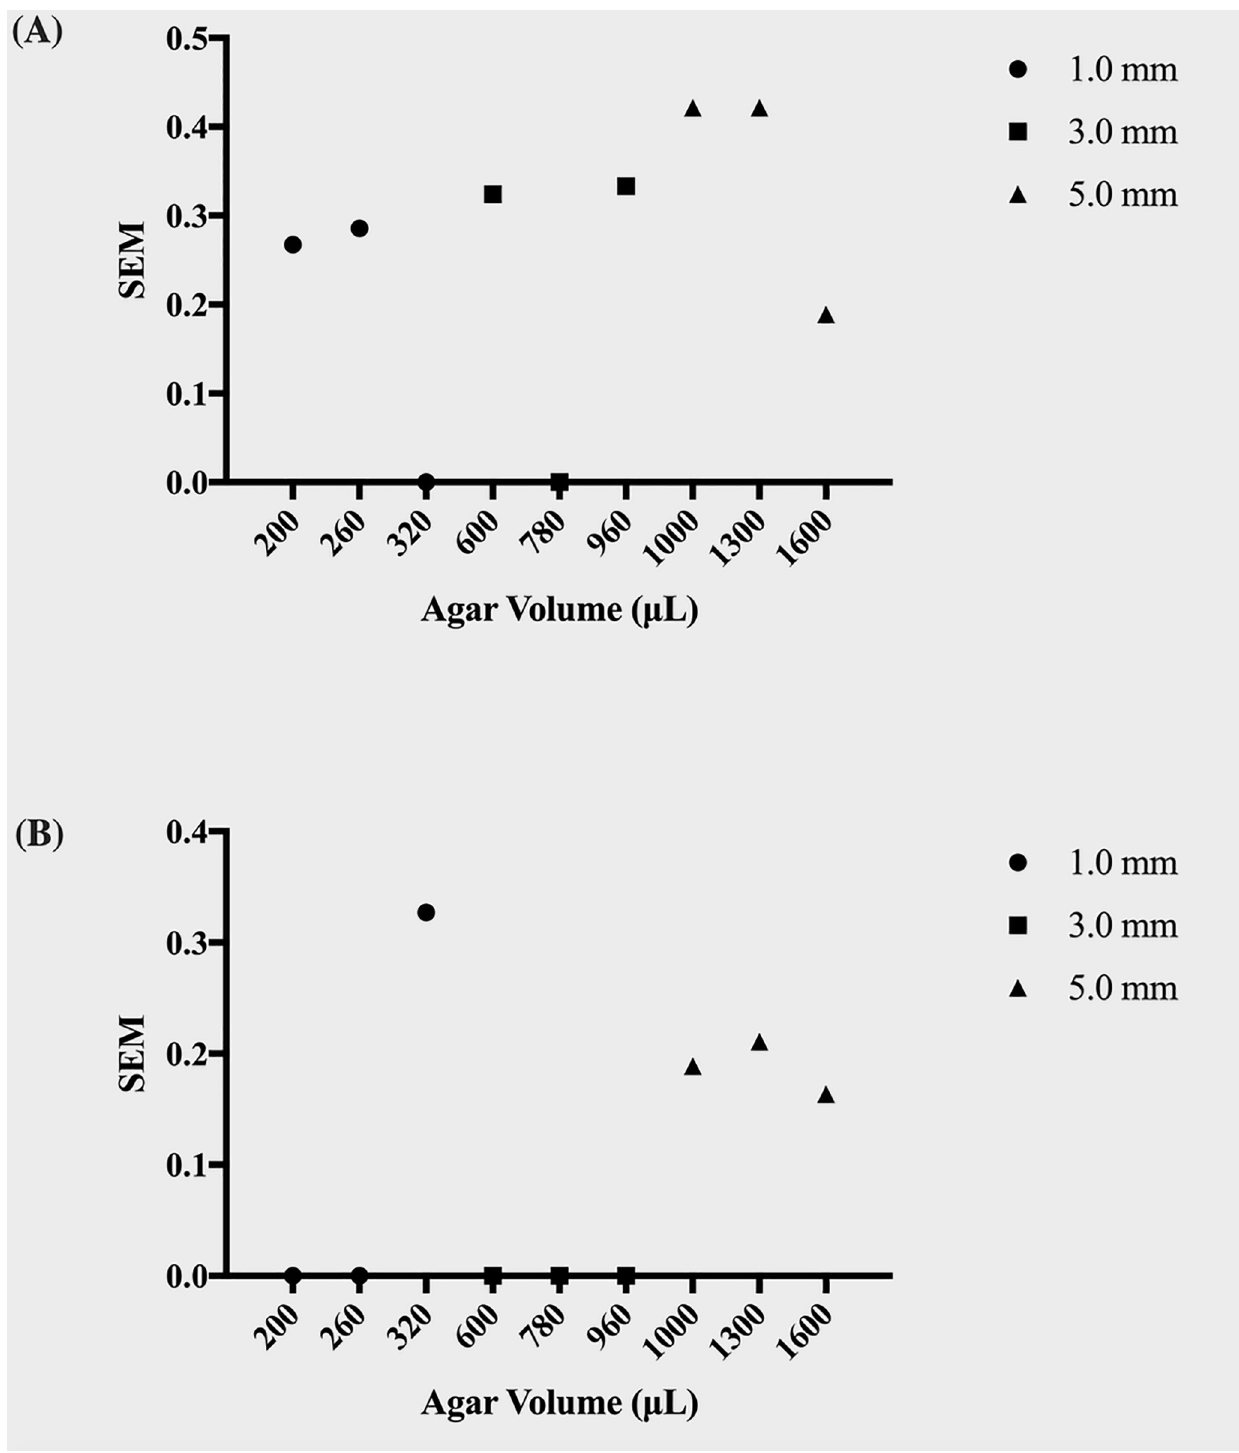
Fig 5. Growth score SEM for pipet and razor-blade microbial inoculation methods. The graphs show the standard error of measurement ( SEM ) for the growth scores of colonies inoculated via (A) pipet-inoculation and (B) razor blade-inoculation across different agar volumes. Note the improved consistency ( SEM = 0) in growth score for the channels inoculated via the latter method.